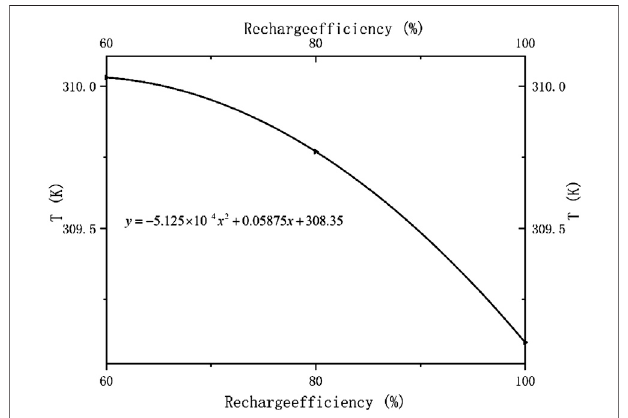
FIGURE 5 | Recharge ef fi ciency-Temperature fi tting curve.